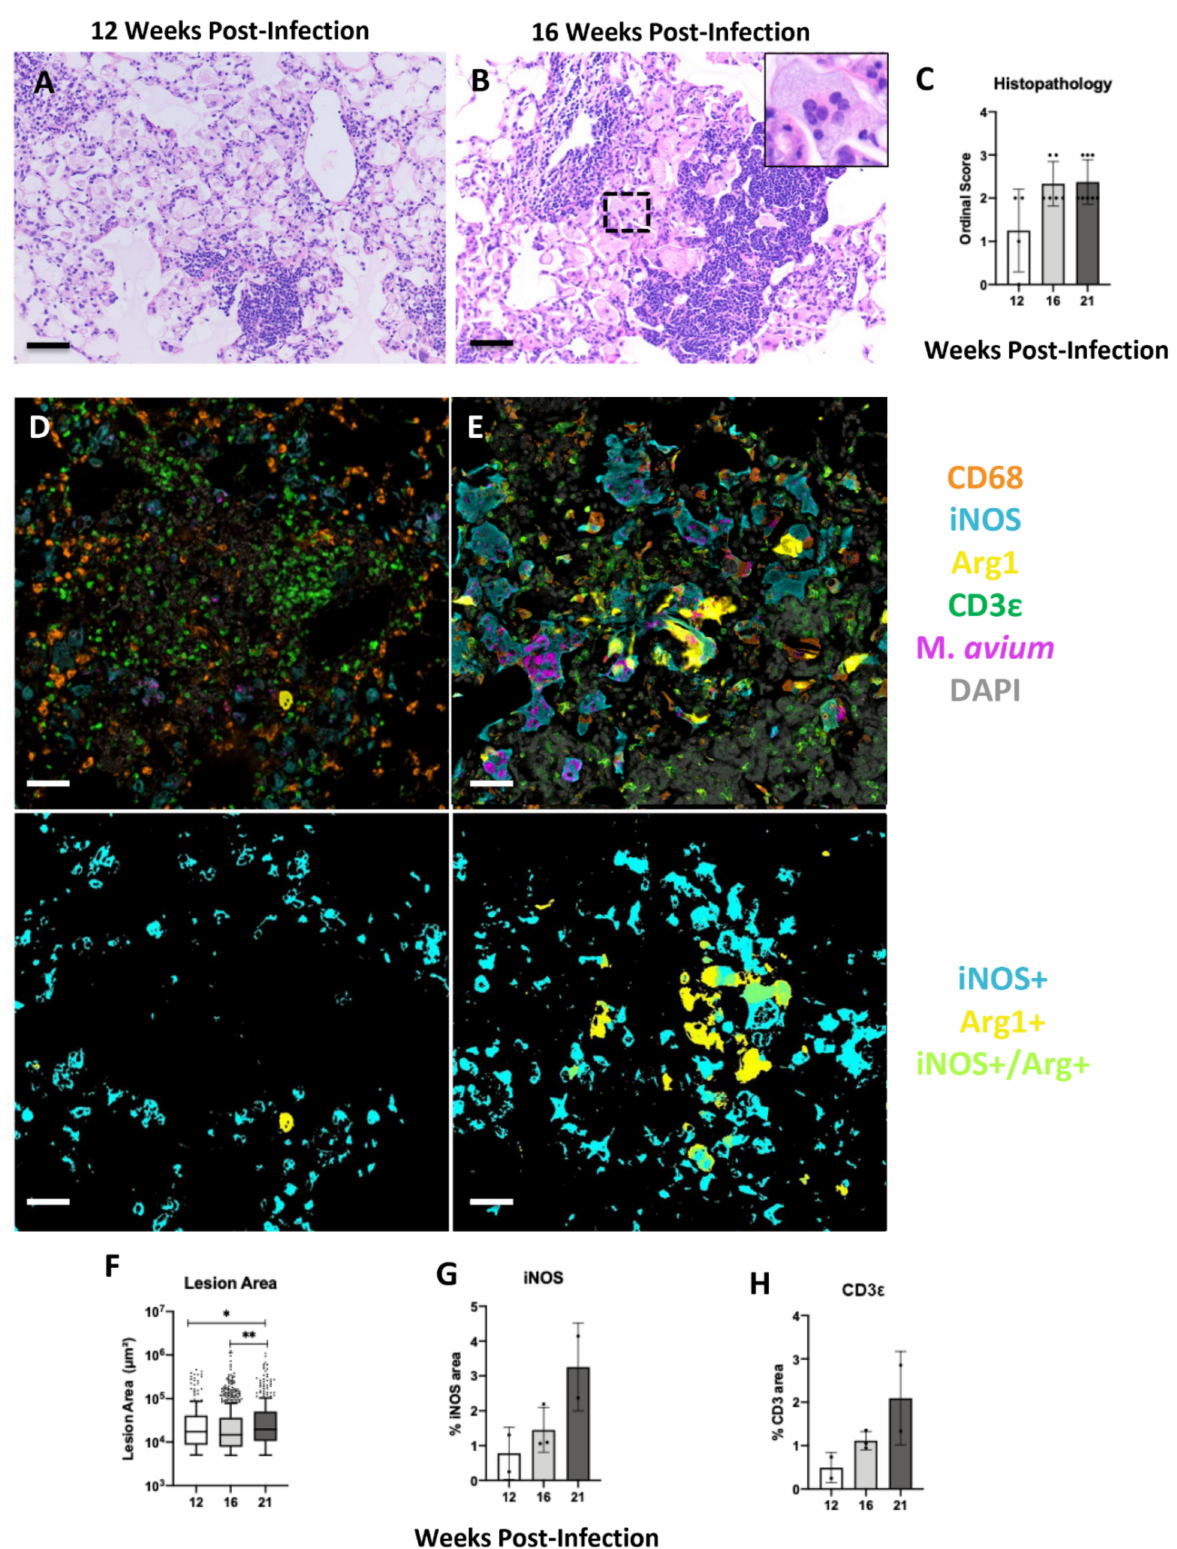
Figure 3. Progression of secondary lesions between 12-, 16-, and 21-weeks-post infection (wpi) in un-inoculated right lung lobes following unilateral left mainstream intrabronchial M. avium inoculation in B6.Sst1S mice. ( A ) representative histological micrograph of early secondary lesion at 12 wpi